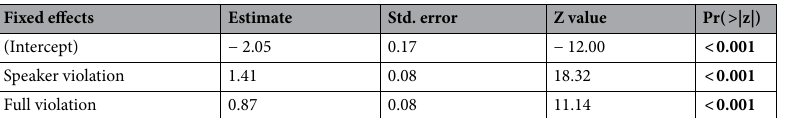
Table 4. Summary of Frequentist Logistic Linear Mixed Effects Model for Experiment 1 with congruent as the reference level. Significant values are in